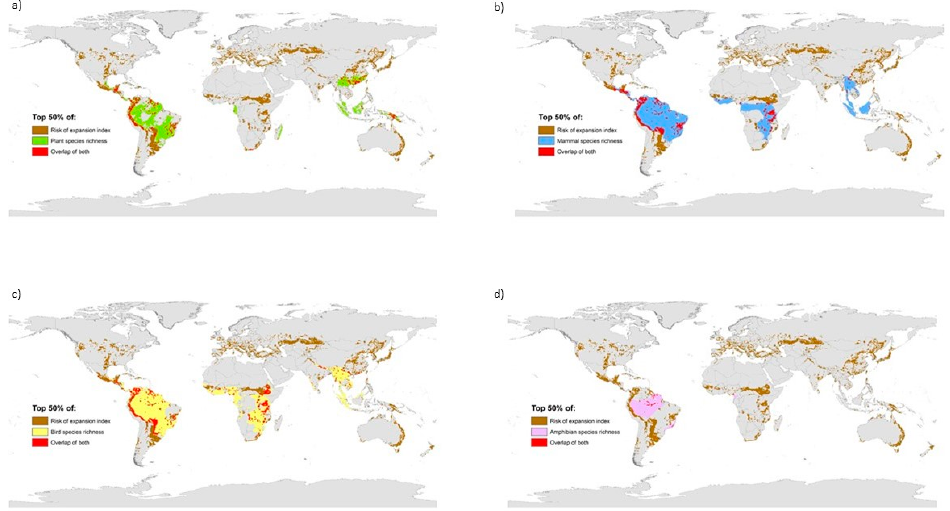
Figure 4. Panel of species richness for ( a ) plants ( b ) mammals ( c ) birds and ( d ) amphibians overlaid with risk of expansion index.